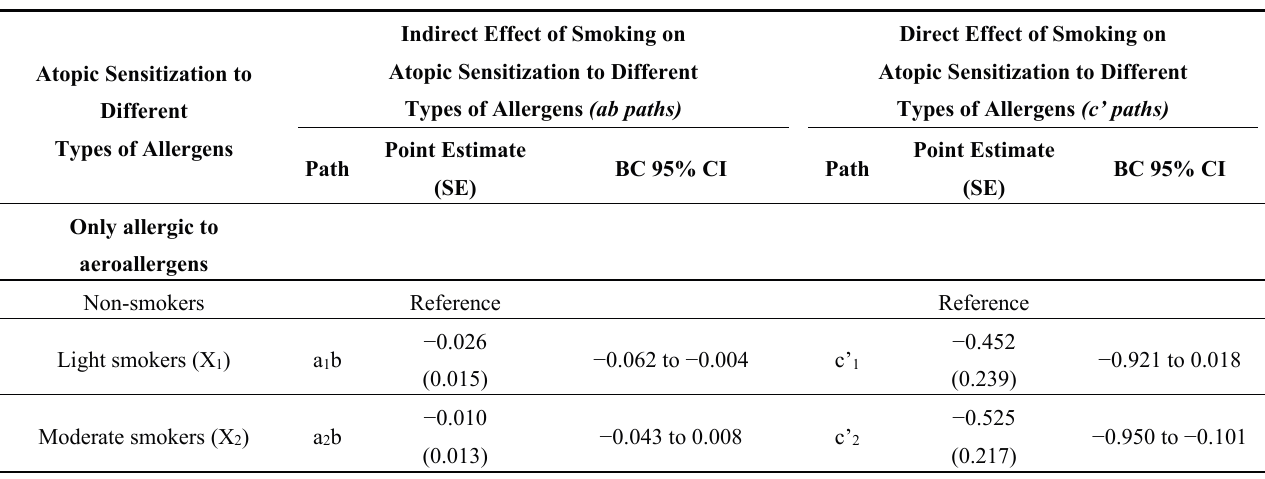
Table 3. Indirect and direct effect, through potential mediator, of smoking categories on atopic sensitization 1